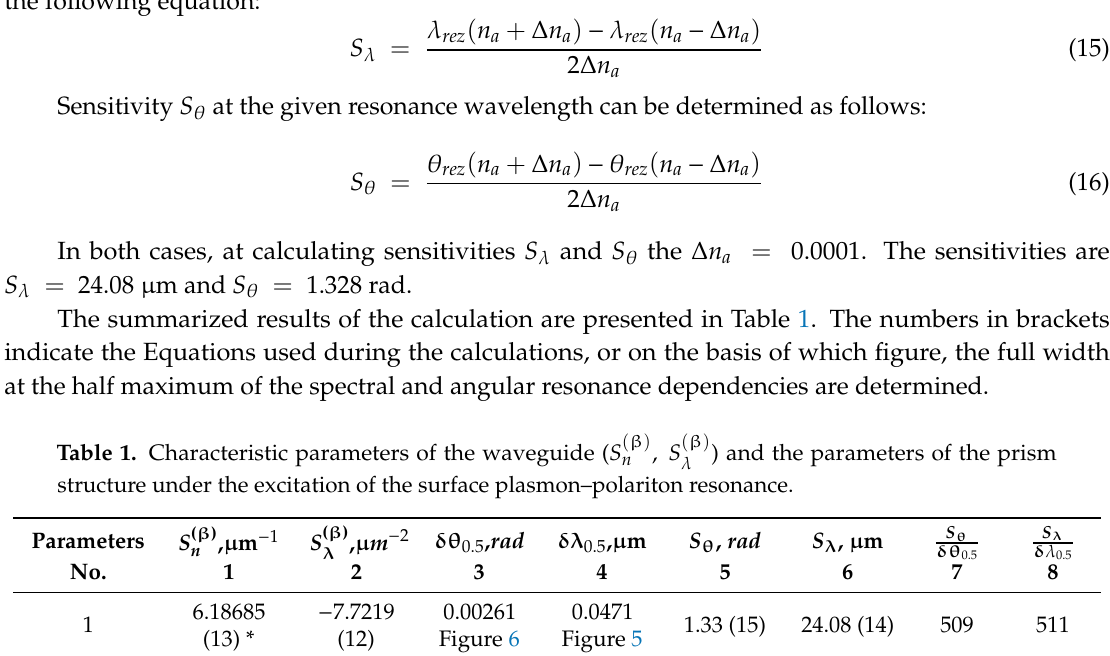
θ = 0.002609 rad. 0.5